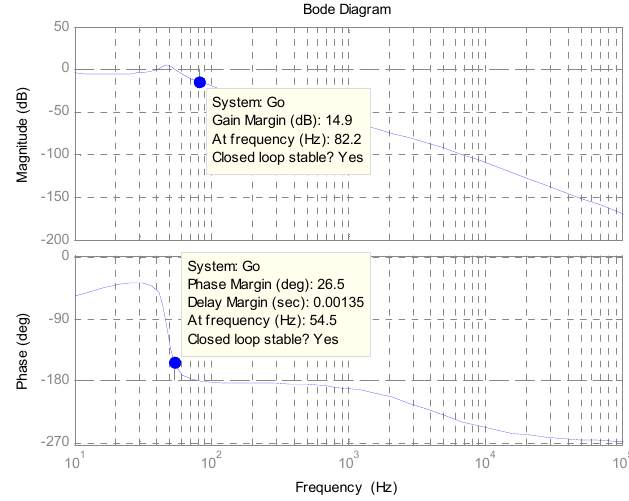
Figure 9. (cid:1833) (cid:3036) transfer function derivation. Figure 9. G i transfer function derivation. Figure 9. (cid:1833) (cid:3279)(cid:3278) (cid:3036) (cid:3290) (cid:3036) (cid:3279)(cid:3278) (cid:3036) (cid:3290) transfer function derivation. dc i o Bode Diagram